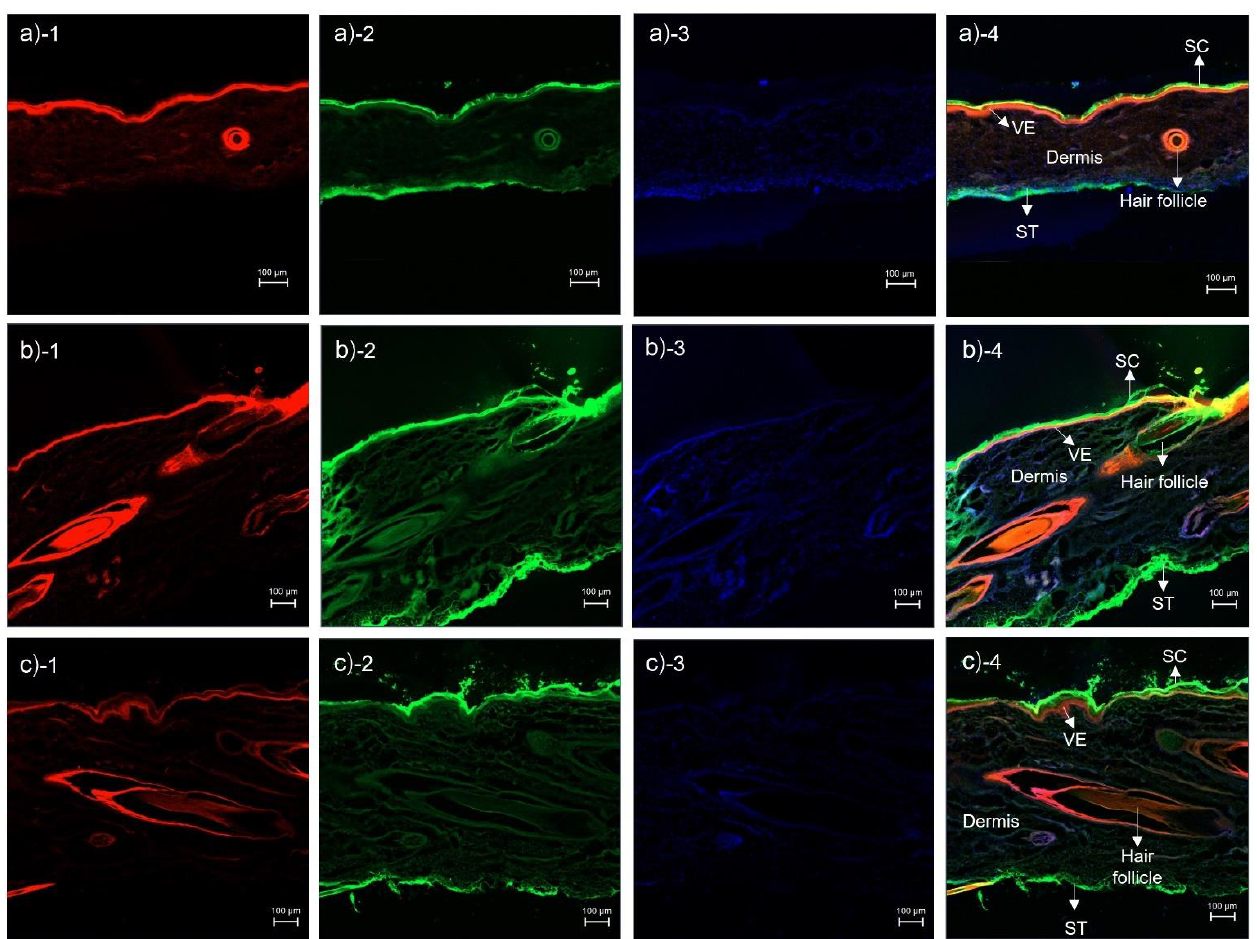
Figure 5. CLSM images of cross-sectioned pig skin treated with rhodamine B base-loaded NBD-PE probed microemulsions and stained with DAPI at ( a ) 30 min, ( b ) 1 h, and ( c ) 2 h. (1) Red fluorescence from rhodamine B base, (2) green fluorescence from NBD-PE, (3) blue fluorescence from DAPI, and (4) merged image of (1) and (2). The scale bar represents 100 µm. SC = stratum corneum, VE = viable epidermis, ST = subcutaneous tissue.